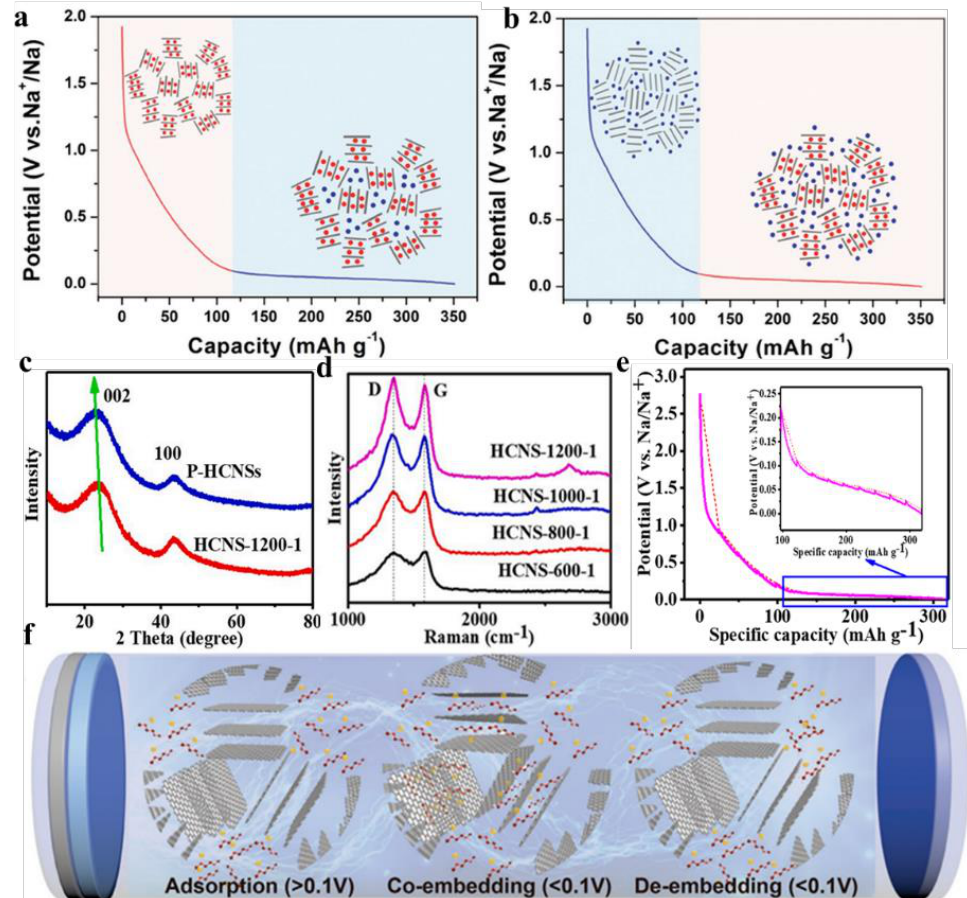
Figure 2. Model of sodium-storage mechanism using hard carbon; ( a ) embedding-adsorption mechanism; ( b ) adsorption-embedding mechanism [86] (copyright Wiley, 2017); ( c ) XRD of P-HCNS and CNS-1200-1; ( d ) Raman of HCNSs; ( e ) the GITT Curves of CNS-1200-1 [82] (copyright Elsevier, 2021); ( f ) schematic diagram of adsorption-co-embedding mechanism [91] (copyright Wiley, 2022).